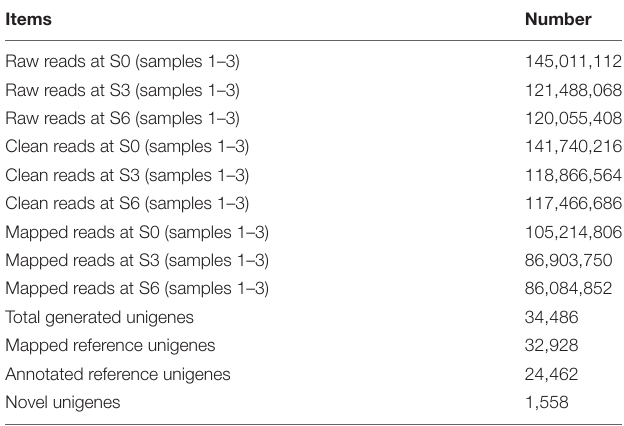
TABLE 1 | Summary of TRV PPK20-infected petunia transcriptome sequencing